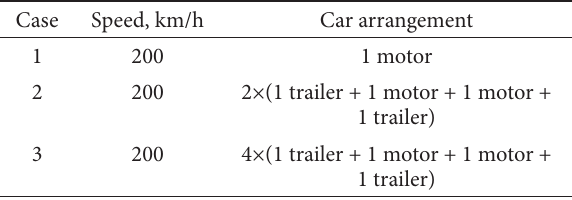
Table 5. Different train car arrangements considered Case Speed,